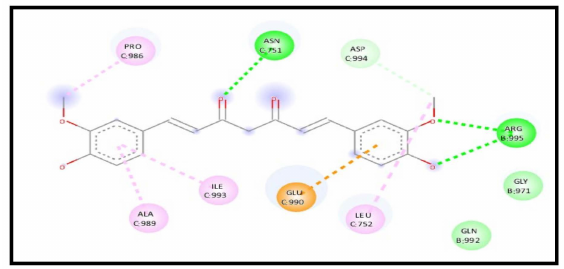
Figure 15. 2D interaction of curcumin–NLC with ACE 2 binding receptor (7KNH) in a